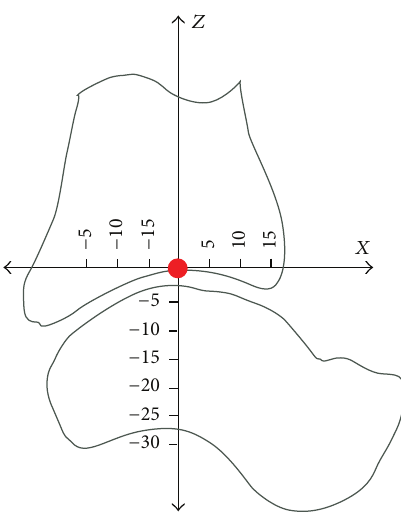
Figure 7: The “ankle coordinate frame” designated to plot the IAR on individual specimen. It was defined as the intersection of bisector of the tibia and the highest point on the tibial mortise.